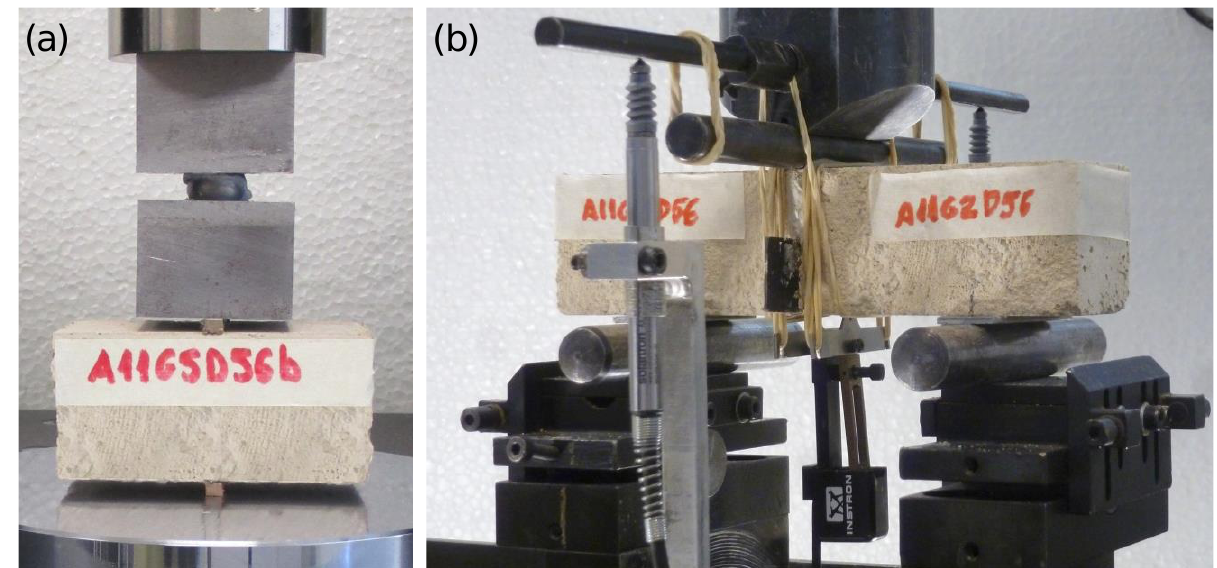
Figure 1. Tests set-up for: (a) splitting tensile strength, (b) fracture energy and elastic modulus.